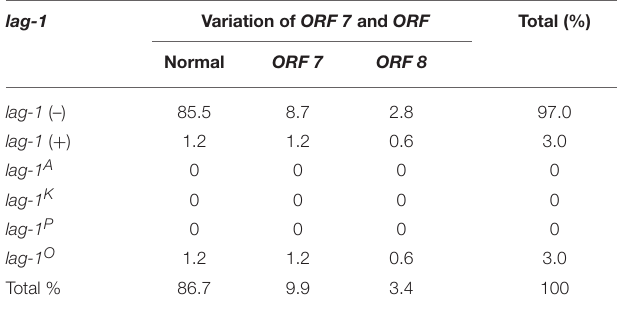
TABLE 4 | Chinese environmental isolates ( n = 172) were divided into 15 subgroups of sg1.